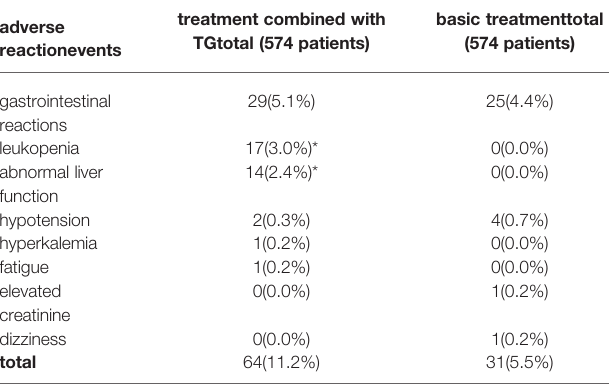
TABLE 2 | Statistics of adverse reaction events after 3-month treatment.